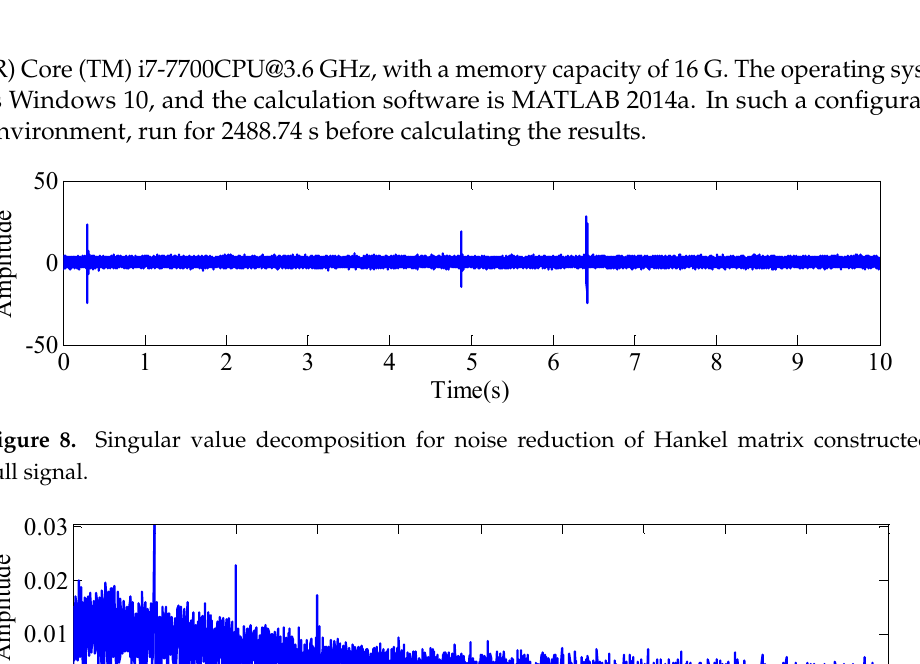
Figure 9. Singular value decomposition of Hankel matrix constructed by full signal to reduce the envelope spectrum of noise signals.